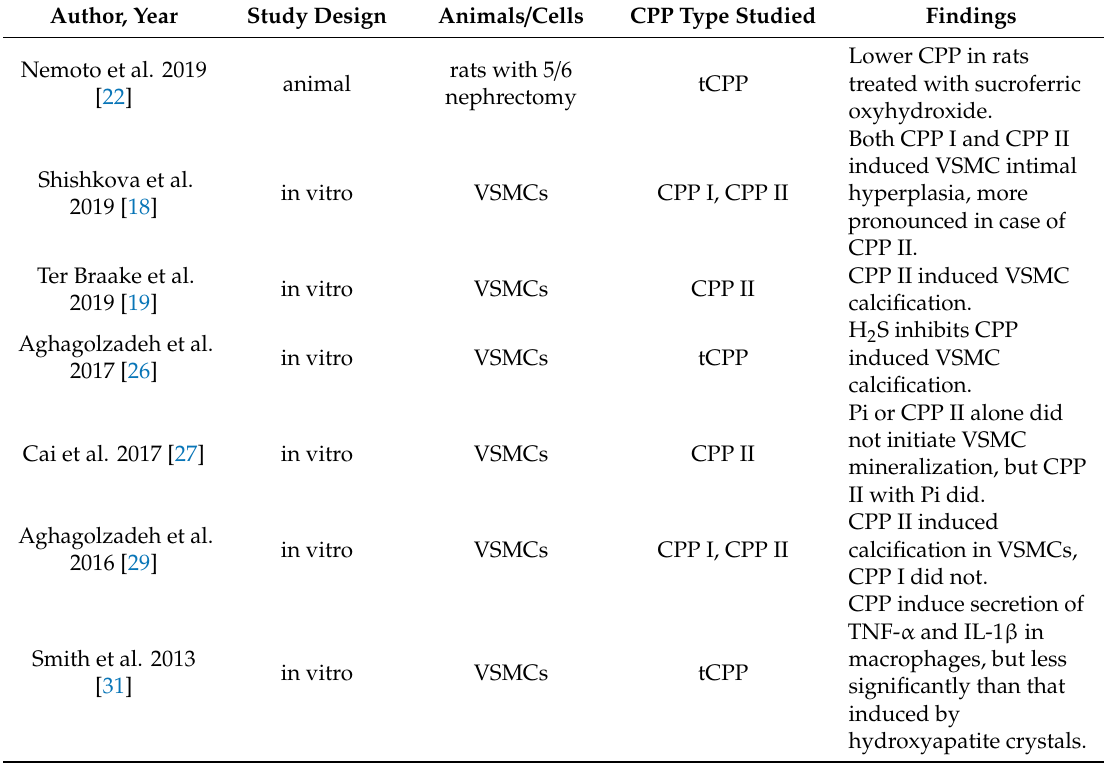
Table 2. Summary of 1 animal and 6 in vitro studies on